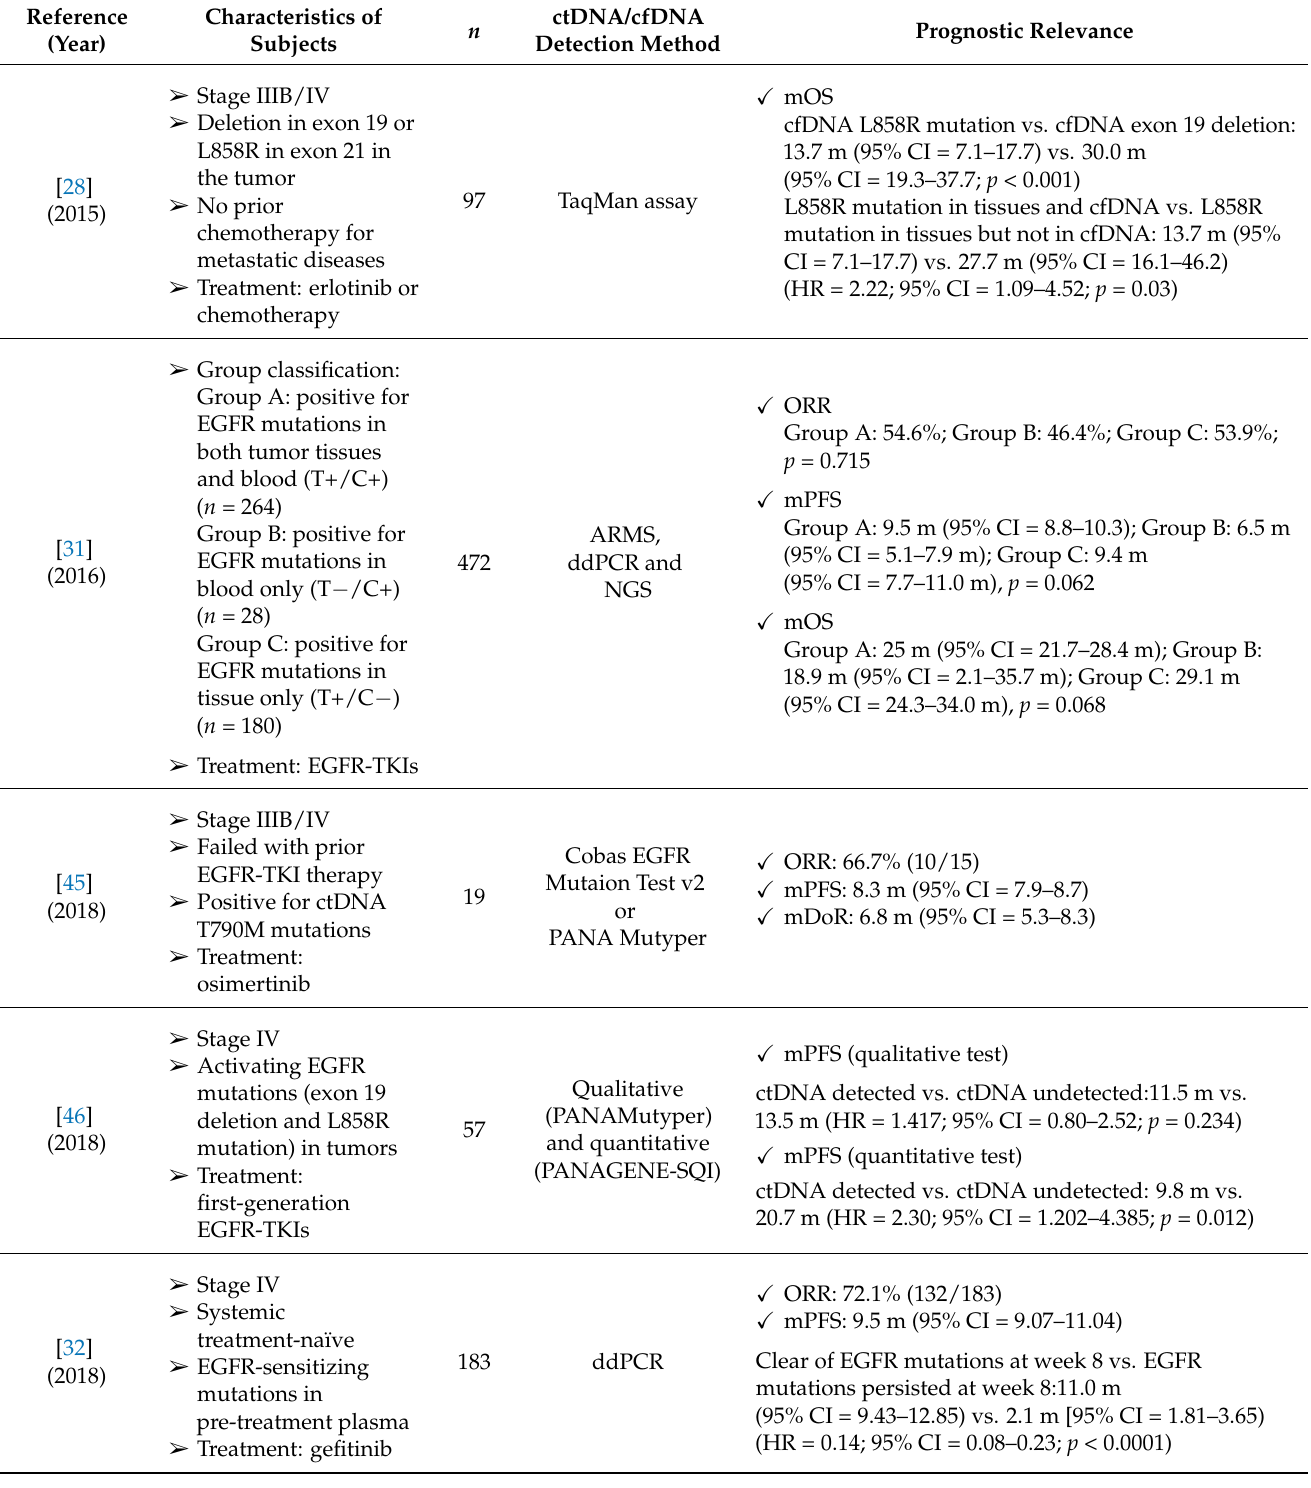
Table 1. The correlation between plasma ctDNA/cfDNA EGFR mutations and the efficacy and prognosis of EGFR-TKI targeted therapy in patients with